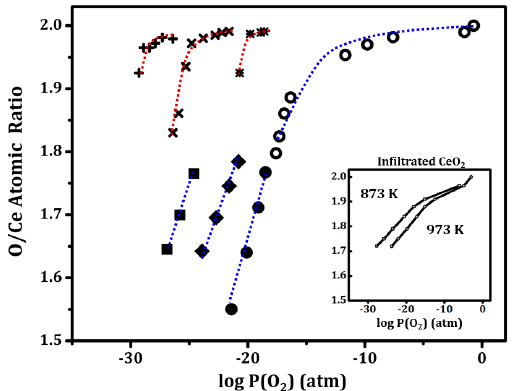
Figure 4. Oxidation isotherms for 20CeO 2 –Al 2 O 3 at selected temperatures (873 K, 973 K, 1073 K). The results for pure ceria were obtained from a previous publication from our group [19], and were determined by flow titration at (+)—873 K, ( × )—973 K, and (*)—1073 K. The ( (cid:4) ), ( (cid:78) ), and ( ) symbols show the isotherms for 20CeO 2 –Al 2 O 3 determined by flow titration at 873 K, 973 K and 1073 K respectively. The ( ) symbol shows the isotherm for 20CeO 2 –Al 2 O 3 determined by coulometric (cid:35) titration at 1073 K. For comparison, previous results for infiltrated ceria on alumina-based support obtained from coulometric titration at 873 K and 973 K are shown